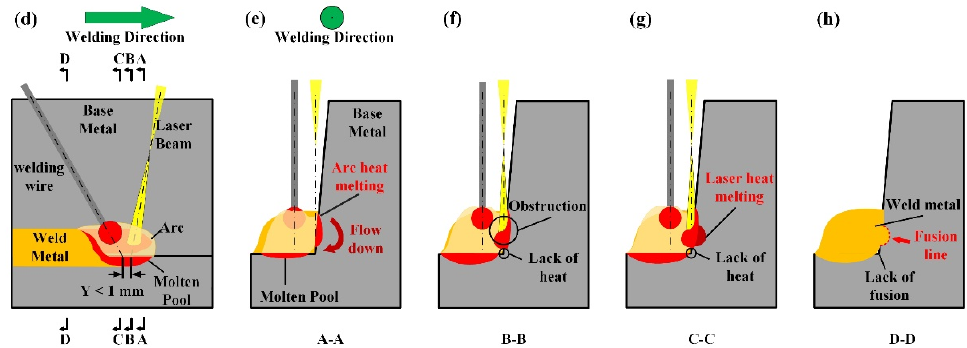
Figure 7. ( a – c ) images of welding process; ( d – h ) schematic diagram of the lack of fusion defects formed at the weld root.